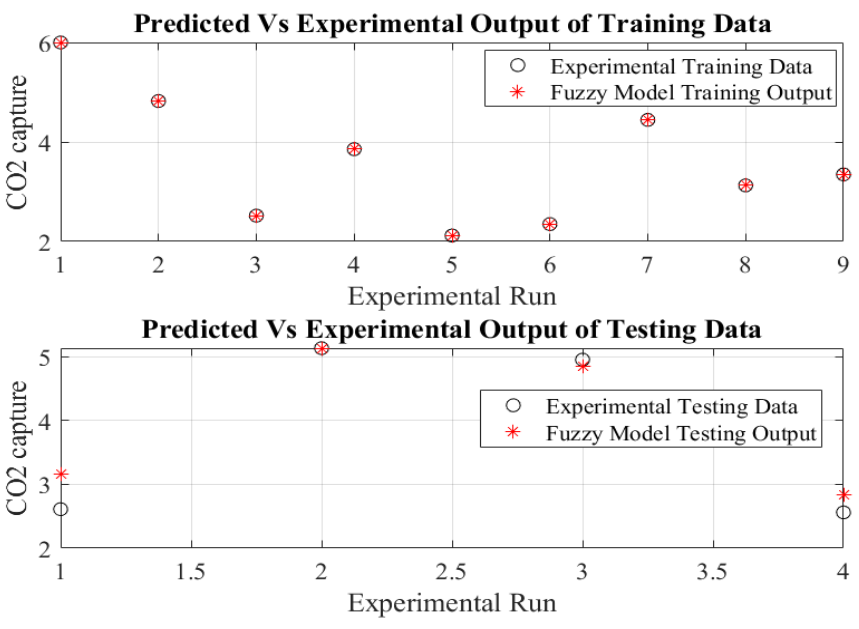
Figure 4. Predicted versus measured data of fuzzy model of the CO 2 capture process.